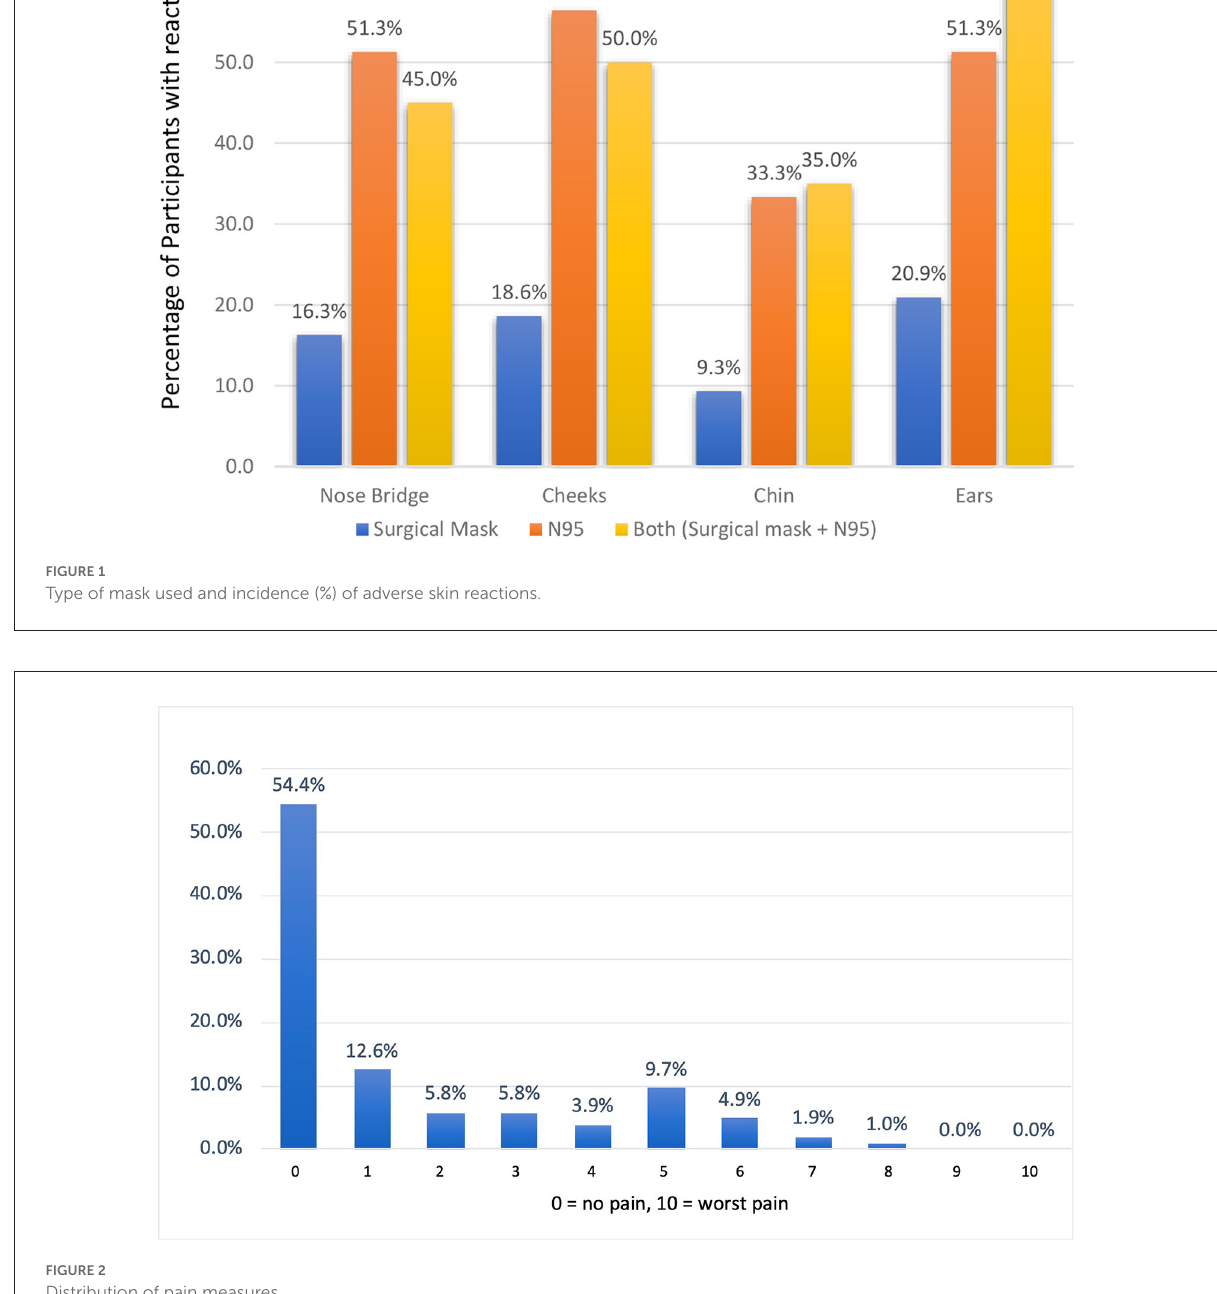
FIGURE2 Distribution of pain